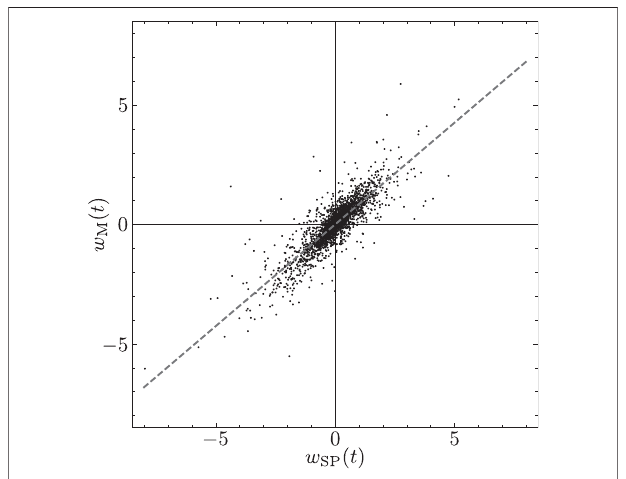
FIGURE6| ScatterplotofthenormalizedS&P500index w SP ( t ) andthe normalizedmarketindex w M ( t ) .Thedashed lineislinearfunctionwithslope ρ , which is Pearson ’ s correlation index, equal to 0.852, and intercept equal to